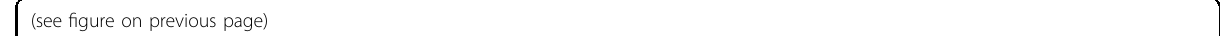
Fig. 2 Sensitivity of MM cell lines to UNC1999 treatment was associated with metabolic alterations in methionine metabolism. a Effects of UNC1999 treatment on cell viability for the indicated cell lines. Biological replicates = 3. Statistical analysis was performed with one-way ANOVA. Values: mean with SEM. b Unsupervised clustering of seven human MM cell lines based on the abundance of all metabolites detected by LC-MS under basal conditions (DMSO treatment only). n (INA-6) = 9, n (U1996) = 11, n (KMS-28PE, U266-1970, LP-1, L363 and OPM2) = 4. c Representative western blot against H3K27me3 in the INA-6 (responsive) and U1996 (non-responsive) cells after UNC1999 treatment, and the relative signal quanti fi cation. d Western blot against H3 in the INA-6 (responsive) and U1996 (non-responsive) cells after UNC1999 treatment, and the relative signal quanti fi cation. The optical density in ( d – e ) was normalized against H4. Statistical analysis in ( d – e ) was performed with a two-tailed t -test. Values: mean with SEM. Data were collected from three biological replicates. The corresponding uncropped western blot fi gures ( d – e ) can be found in Supplementary Fig. 9c. e A principal component analysis (PCA) demonstrating in two dimensions that non-responding and responding samples cluster based on their independent metabolic pro fi les. n (DMSO INA-6) = 9, n (UNC1999 INA-6) = 9, n (DMSO U1996) = 11, n (UNC1999 U1996) = 10. f Heatmap showing the 150 most discriminating metabolites in the dataset, which were signi fi cantly different between INA-6 and U1996 after UNC1999 treatment. The colour bar describes the intensity of the change in metabolite levels: deeper colour determines the different magnitude of regulation. Red indicates upregulation and blue indicates downregulation. n (DMSO INA-6) = 9, n (UNC1999 INA-6) = 9, n (DMSO U1996) = 11, n (UNC1999 U1996) = 10. g – h Metabolite set enrichment analysis (MSEA) ( g ) in INA-6 and ( h ) non-responsive cell lines after UNC1999 treatment. n (DMSO INA-6) = 9, n (UNC1999 INA-6) = 9, n (DMSO KMS-28PE) = 4, n (UNC1999 KMS-28PE) = 4, n (DMSO U266-1970) = 4, n (UNC1999 U266-1970) = 4, n (DMSO u1996) = 11, n (UNC1999 U1996) = 10. * p < 0.05, ** p < 0.01, *** p < 0.001, **** p <